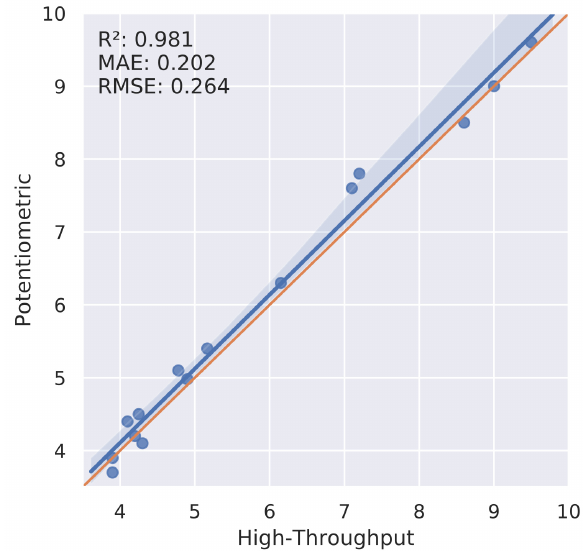
Figure 3. Correlation of Novartis compounds measured in potentiometric and high-throughput (capillary electrophoresis) set-up. MAE, mean absolute error; RMSE, root mean square error.